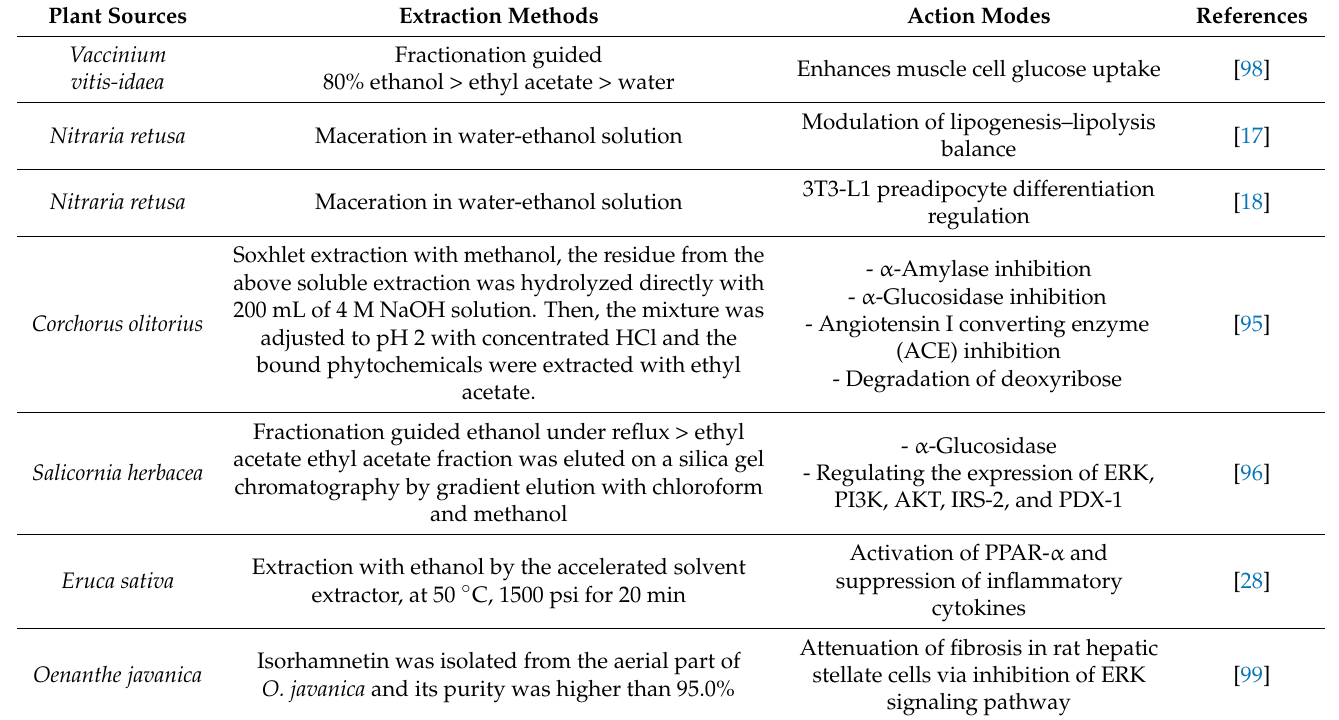
Table 1. Isorhamnetin resources cited in the current